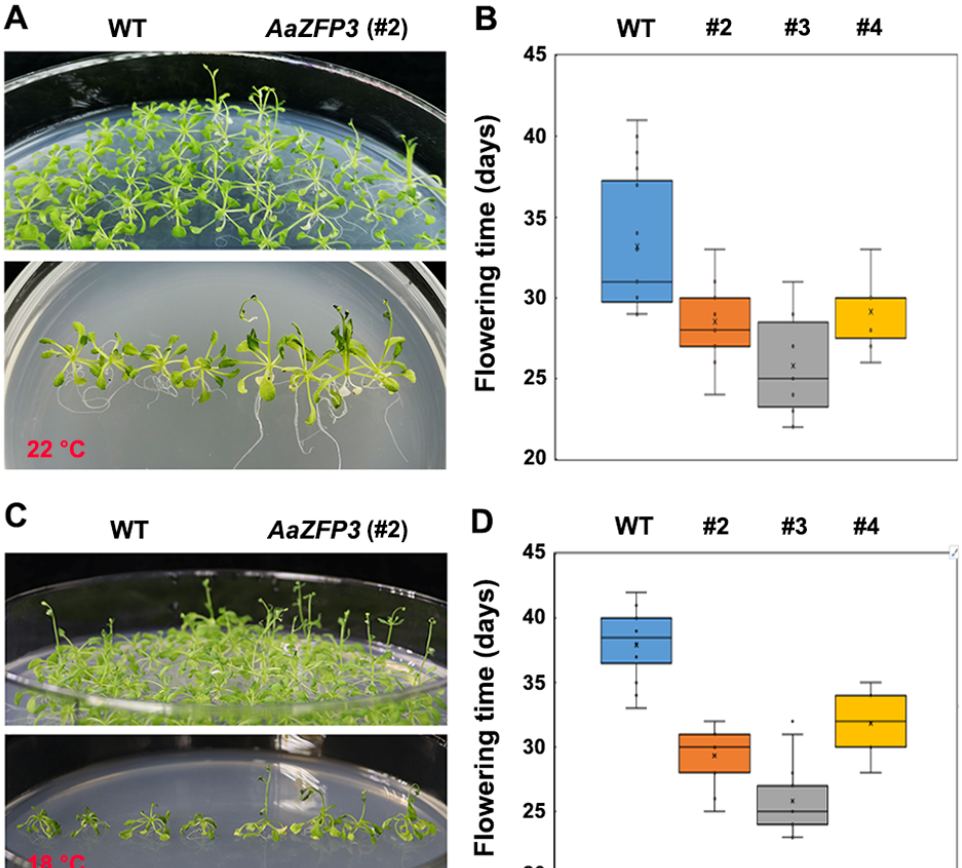
Figure 4. Flowering time of medium-grown wild-type (WT) and transgenic Arabidopsis plants overexpressing AaZFP3 . Flowering phenotype and box plots of flowering time of WT and transgenic Arabidopsis plants (#2, #3, #4) grown on plates containing 1/2 MS medium under a 12 light/12 h dark photoperiod at 22 °C ( A , C ) or 18 °C ( B , D ). The interquartile range box represents the middle 50% of the data. Whiskers extend 1.5 times the interquartile range and the center line marks the median. n ≥ 15 plants pre line.